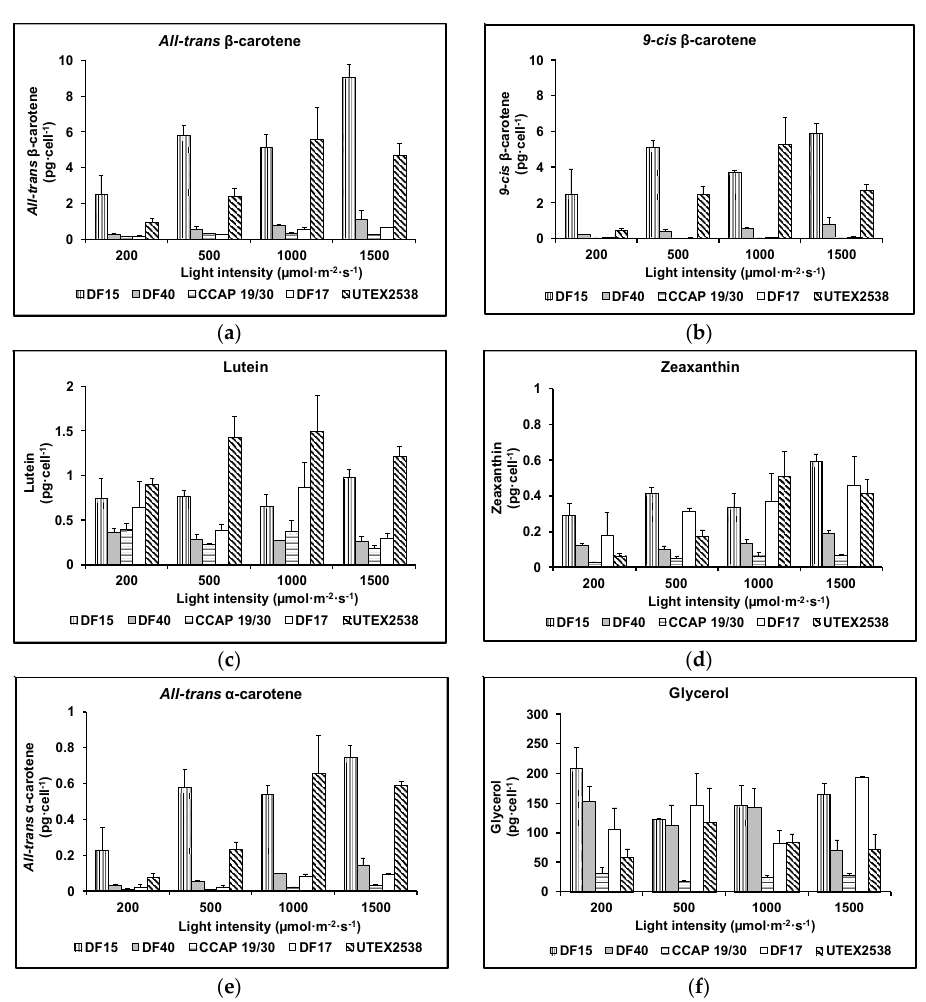
Figure 6. Cellular contents of ( a ) all-trans β -carotene, ( b ) 9-cis β -carotene, ( c ) lutein, ( d ) zeaxanthin, ( e ) all-trans α -carotene and ( f ) glycerol in the five Dunaliella strains cultivated under four light intensities of 200, 500, 1000, and 1500 µmol·m − 2 ·s − 1 . Samples were taken at the mid log phase and all culture conditions were repeated at least in triplicate.